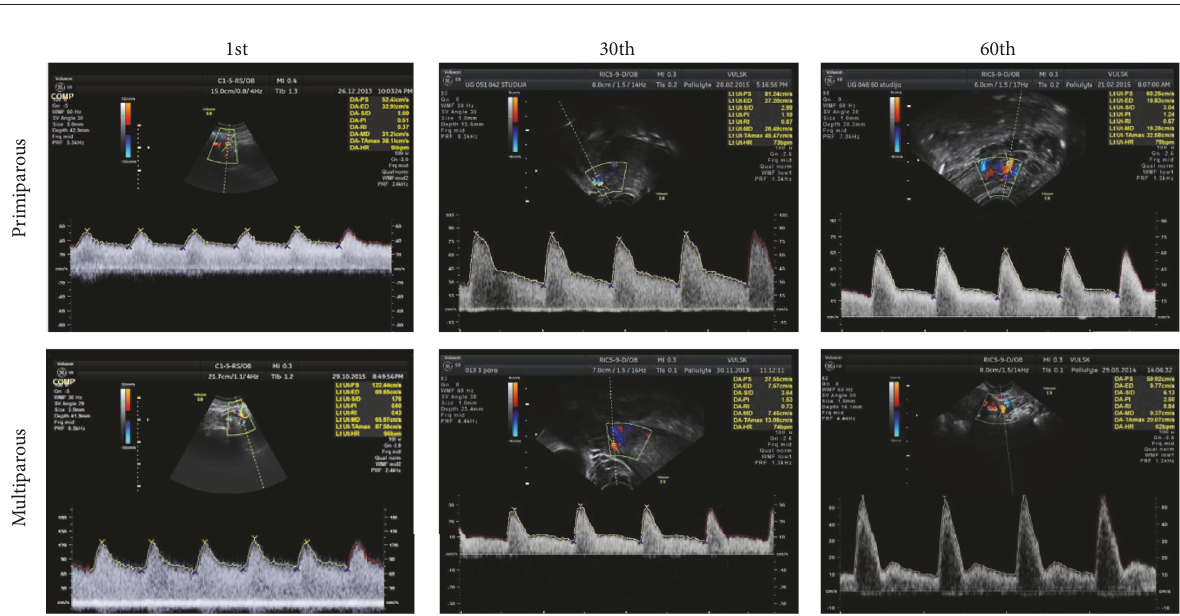
Figure 6: Uterine artery flow changes on the 1st, 30th, and 60th days in primiparous and multiparous